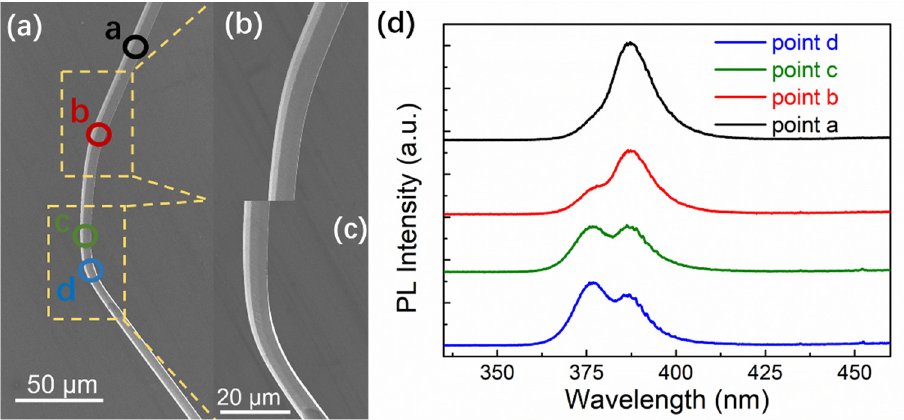
Figure 5. Room temperature PL measurements of different bending regions of ZnO microwire ( d ) and the corresponding focusing areas ( a – c ).